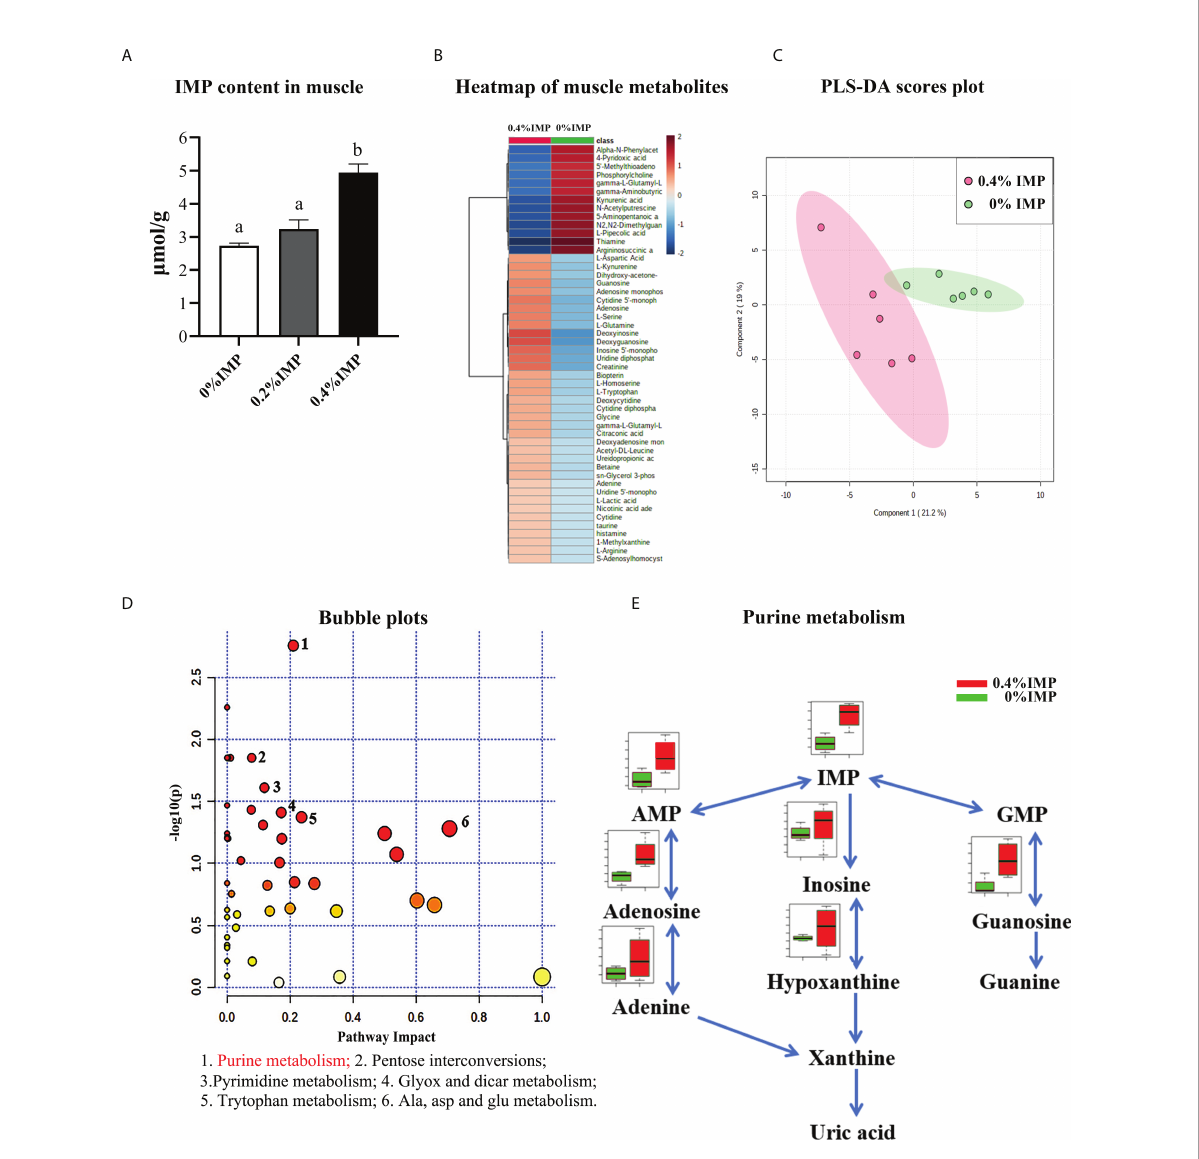
FIGURE 5 Metabolomics analysis — effect of IMP supplementation on muscle fl avour of gibel carp. (A) IMP content in the muscle measured by HPLC. (B) Heat map representing the hierarchical cluster analysis (top 50) in 0%IMP VS 0.4%IMP. Red indicates high abundance, whereas the relatively low-abundance metabolites are shown in blue. (C) The partial least squares discriminant analysis (PLS-DA) score plots for metabolomics of muscle samples. 0.4%IMP group in red; 0%IMP group in green. (D) KEGG pathway enrichment analysis (top 25) of IMP, pathway enrichment in 0%IMP VS 0.4%IMP. The x-axis represents the enrichment ratio, while the y-axis represents the enrichment pathway. (E) integrative map of purine metabolism in muscle tissue. 0%IMP group in red; 0.4%IMP group in